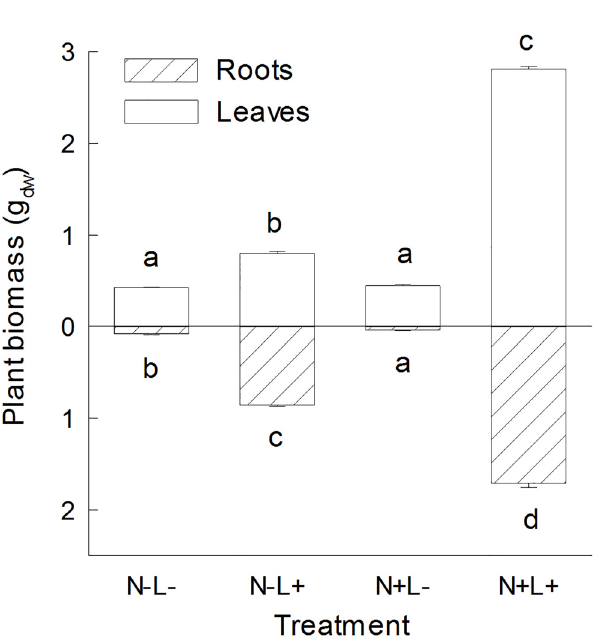
Fig 3. Above- and belowground biomass of leaves and roots of Plantago lanceolata . Plants were grown at different light and nutrient availability (N-: low nutrient, N+: high nutrient, L-: low light, L+: high light). Values are means across all plants per treatment (+ 1 SE). Results of Tukey`s test applied to test for significant differences between different light x nutrient treatments are indicated with